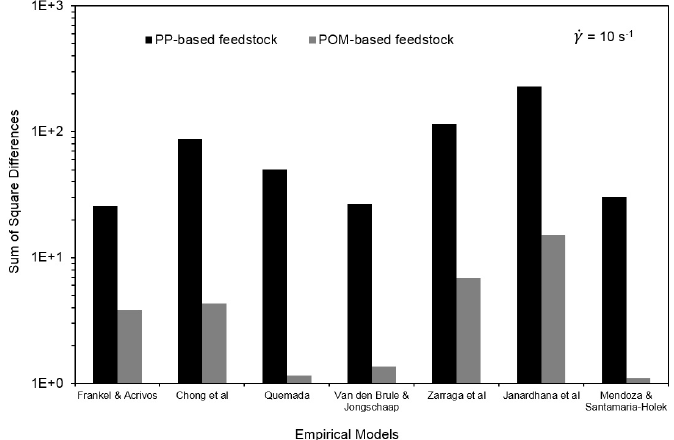
Figure 8. Square difference for models of viscosity as a function of powder loading for PP ‐ based feedstock viscosity at 170 °C and POM ‐ based feedstock viscosity at 180 °C. Only models with maximum one fitting parameters are shown here.